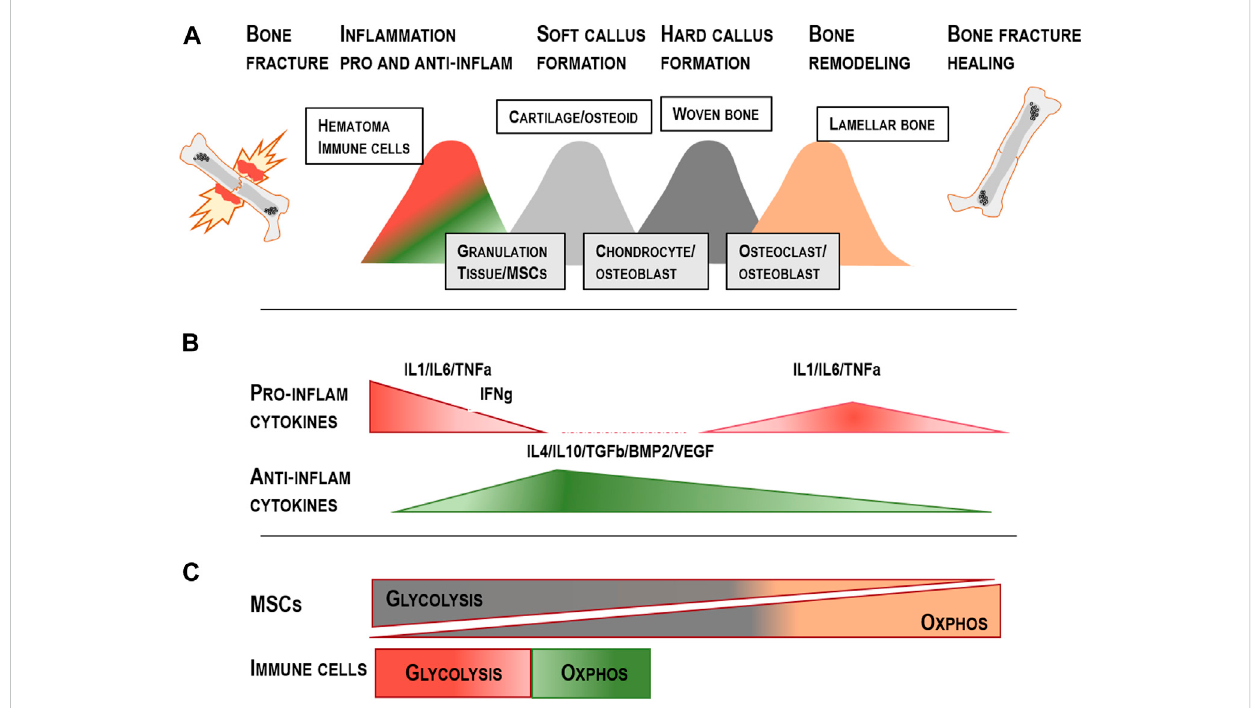
FIGURE 2 Overview ofthe fi vedistinct fracture healingphases: (A) Stage 1:Hematoma formation andpro-in fl ammatorysignalling;Stage 2:Anti-in fl ammatory hematoma; Stage 3: Soft callus development; Stage 4: Hard callus development; Stage 5: Remodelling of the newly formed bone; modi fi ed from Ono, et al. (2017) and Maruyama, et al. (2020). (B) Distinct cytokines affecting the pro- and anti-in fl ammatory phase during the early healing stage, callus formation and remodelling. (C) MSCs change their metabolic features from glycolysis towards OXPHOS during osteogenic differentiation. Monocytes, M1 macrophages and T cells prominently use the glycolytic pathways when differentiation and activation happens and change their metabolism towards OXPHOS when the anti-in fl ammatory phase is induced (Tregs/M2 macrophages) (Fretz et al., 2010; Scheller and Rosen, 2014; Loef fl er et al.,